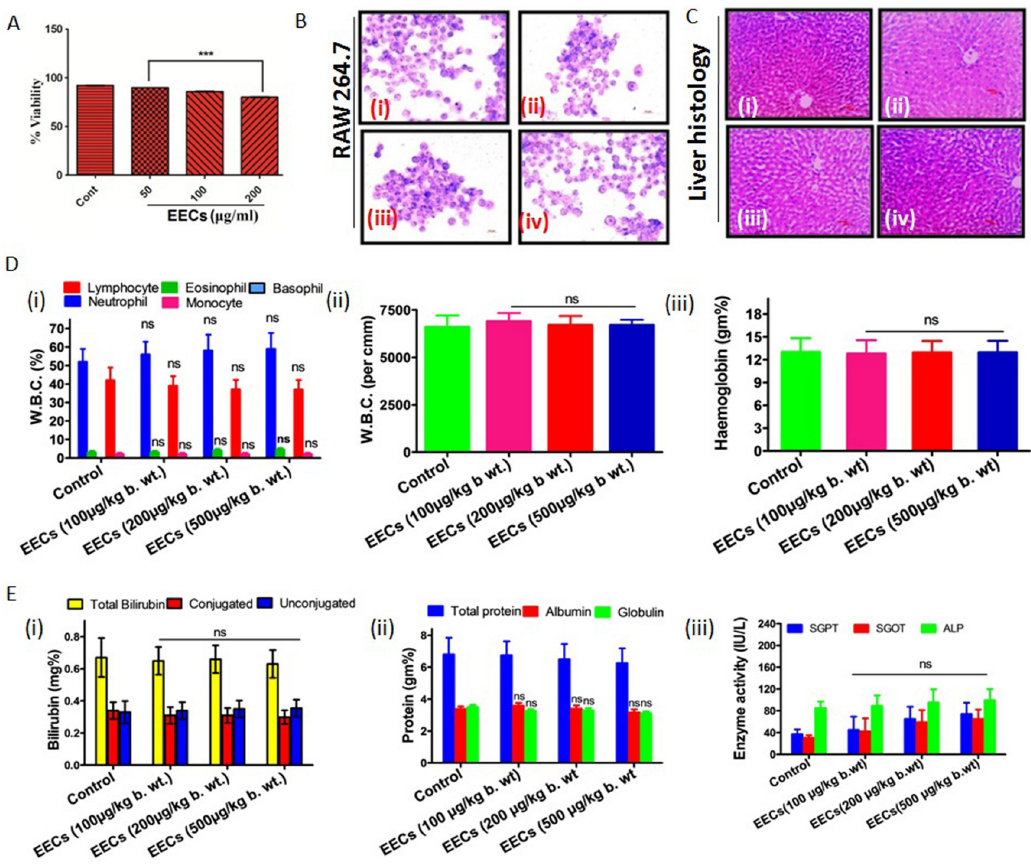
Fig 5. EECs exerts no toxic effect on mammalian cells and tissue. (A.) Viability and (B.) morphology of mouse macrophages (RAW 264.7) treated with EECs. (C.) Histological alteration of liver tissue of Wister rat treated with EECs. (i) represents control; (ii), (iii) and (iv) respectively represent the histological observation of the liver tissue collected from the rats treated with 100, 200 and 500 μ g/kg body weight. (D.) Alteration in the hematological parameters such as (i) % WBC; (ii) WBC per cubic mm; and (iii) % hemoglobin in the control and EECs treated rats (E.) Alteration in hepatic biomarkers (i) serum bilirubin; (ii) serum proteins and (iii) activities of the serum transaminases (SGPT, SGOT, and ALP) and alkaline phosphates. Each data is a representative of experiments conducted in triplicate and repeated for a further five